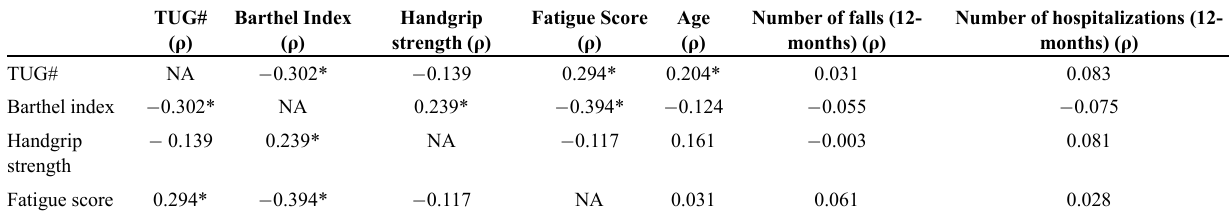
Table 5 - Correlations between functional outcome measures, age, number of falls, and hospitalizations within 12-months (n =